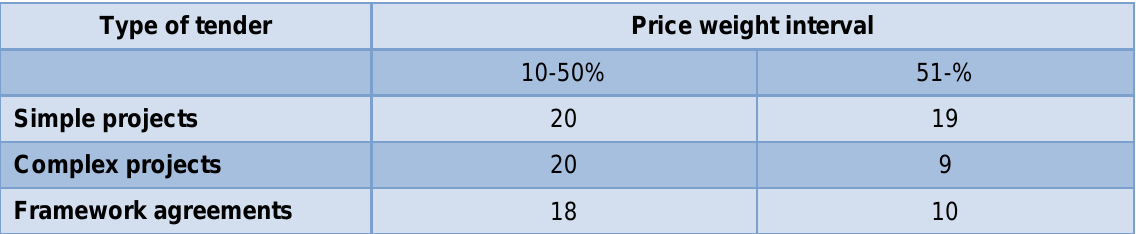
Table 3 Number of municipalities by tender type and price weight interval Sources of Information